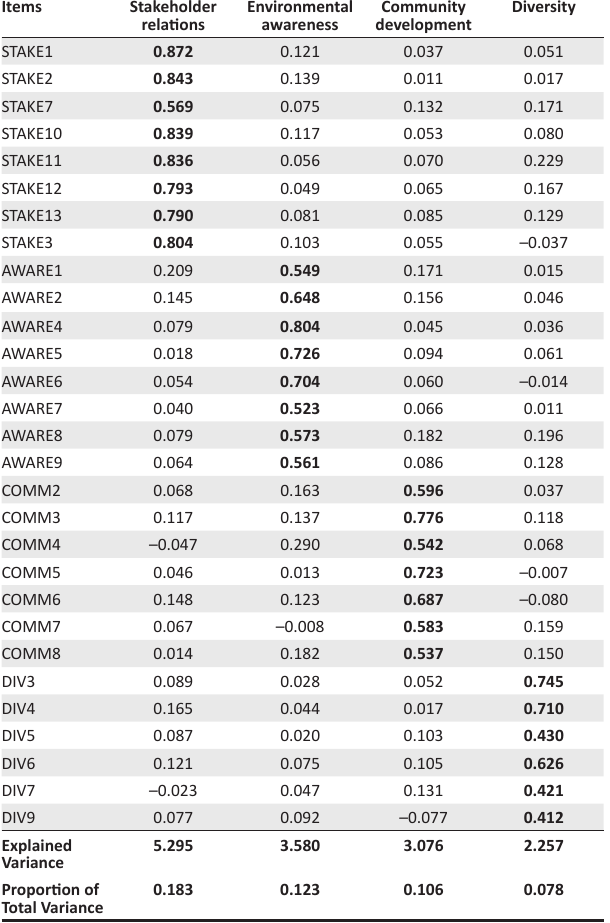
TABLE 1: Factor structure – independent